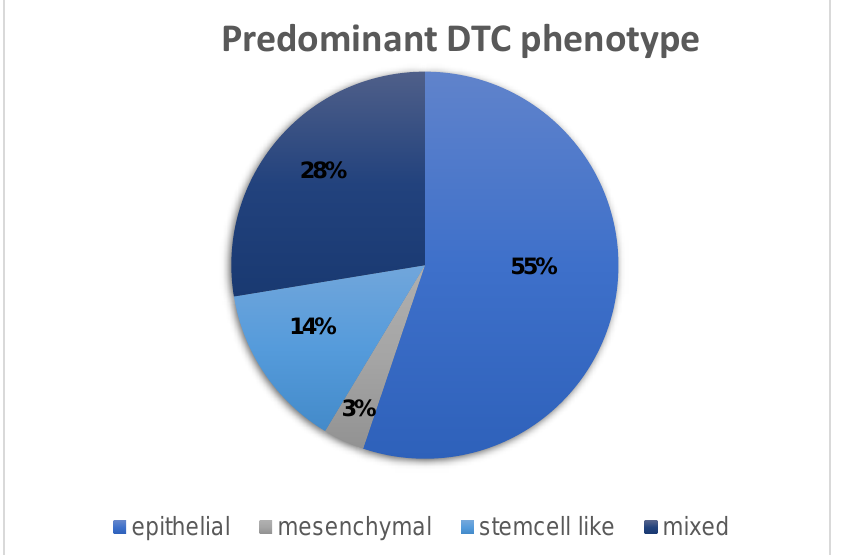
Figure 8. Distribution of DTC phenotypes among the HR+ cohort of 29 patients.